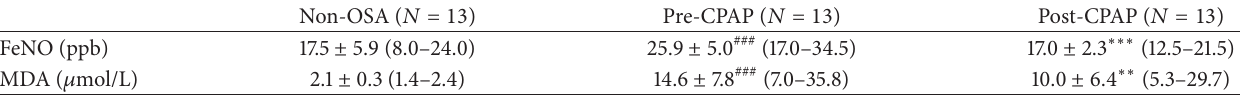
Data are presented as mean ± SD. FeNO: fractional exhaled nitric oxide; MDA: malondialdehyde; ppb: parts per billion. ∗∗ 𝑃 < 0.01 and ∗∗∗ 𝑃 < 0.001 pre-